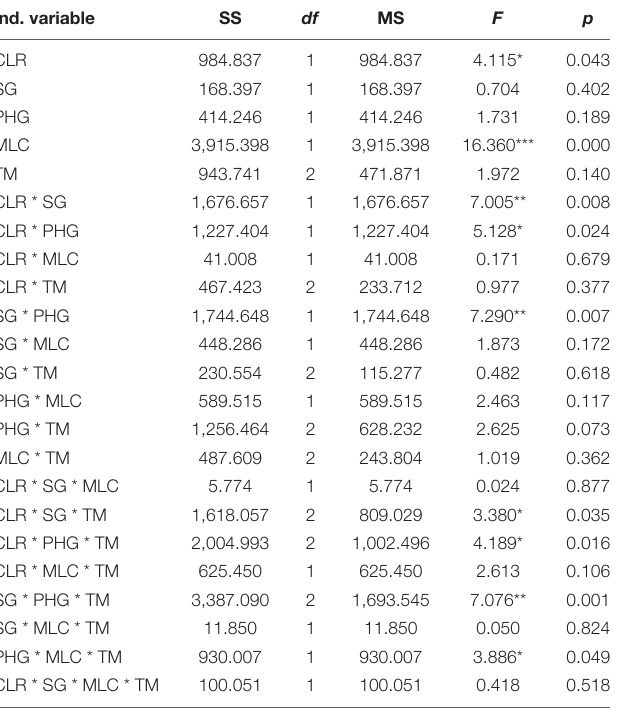
TABLE 1B | Comparison of learning motivations by temperament type and teaching mode (analysis of variance). Ind. variable